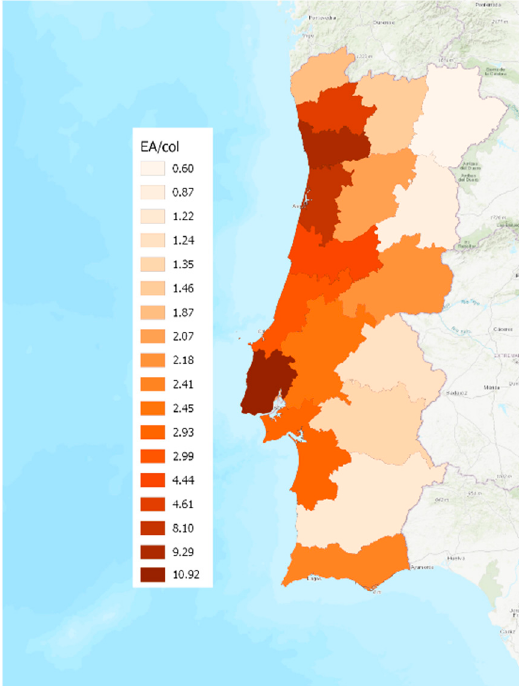
Figure 12. EAM per coverage station (map elaborated with QGIS).